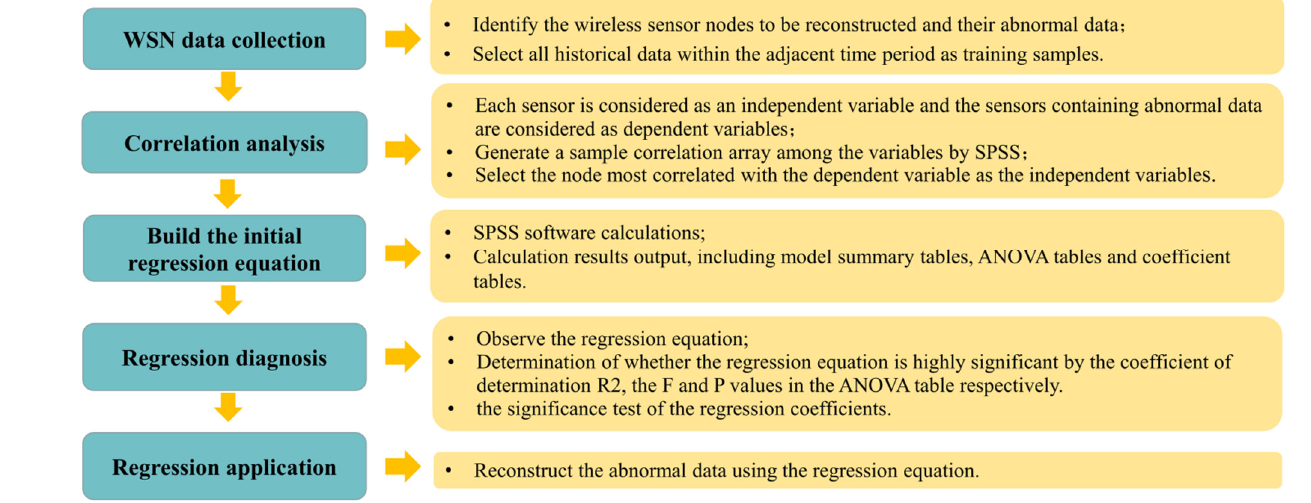
Figure 5. Steps of multiple linear regression based on SPSS.